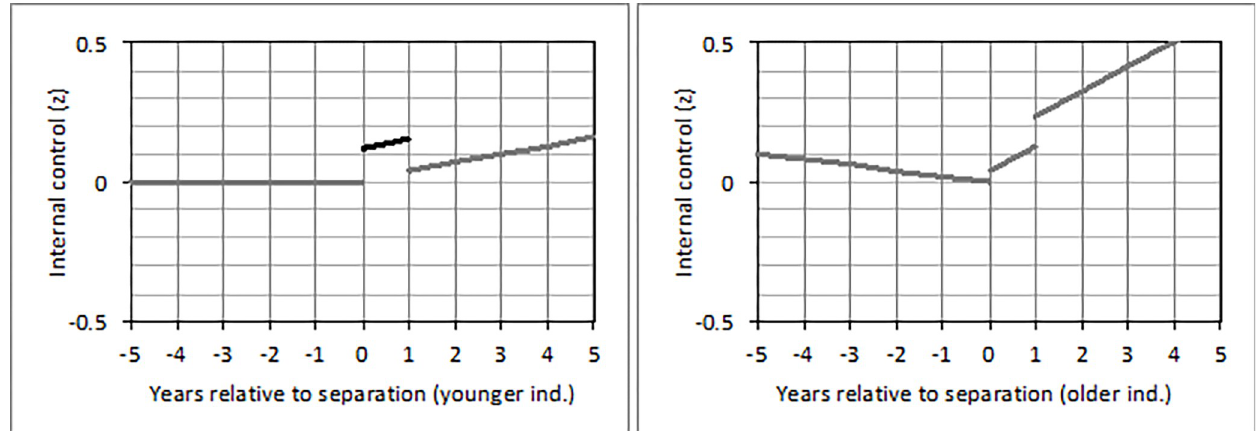
Fig 4. Changes of internal control beliefs from five years before until five years after separation from a partner in (a) younger and (b) older individuals who experienced this loss between 1991 and 1999. Note . A detailed description of the figure can be found in Fig 1. The second line in (a) is marked in black because the short-term effect reached statistical significance ( p < .05) only in younger but not in older individuals.